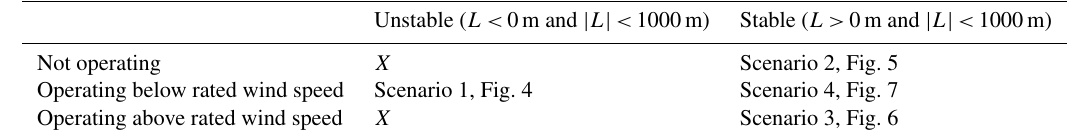
Table 1. Summary of possible scenarios to be analysed. Those shown in this work are named; those not shown are marked as X